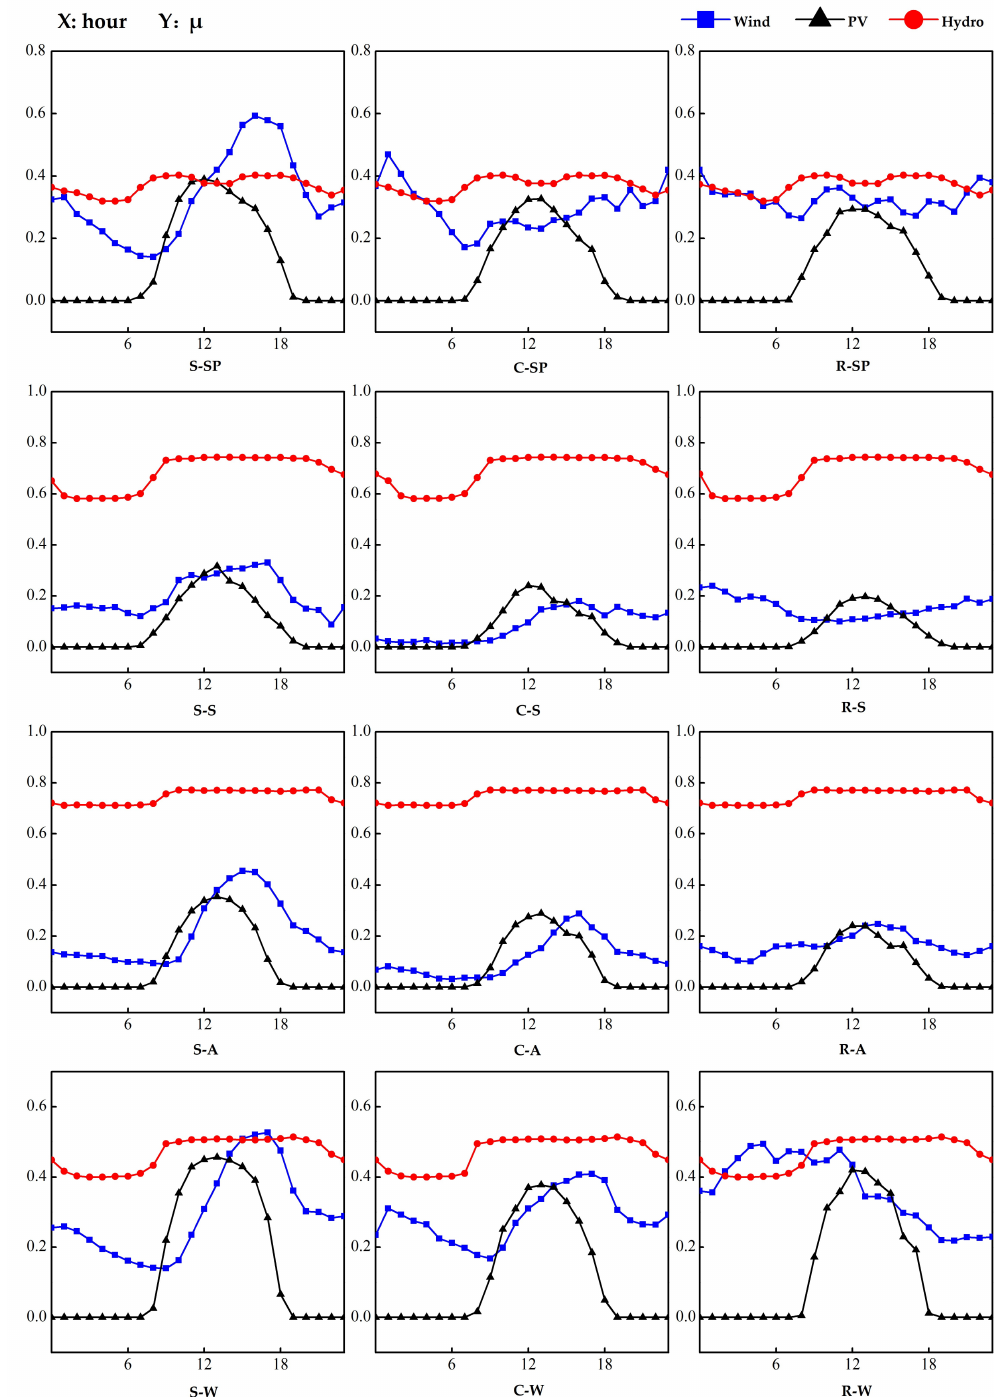
Figure 4. Wind power, photovoltaic, and hydropower output processes in one day of the 12 typical